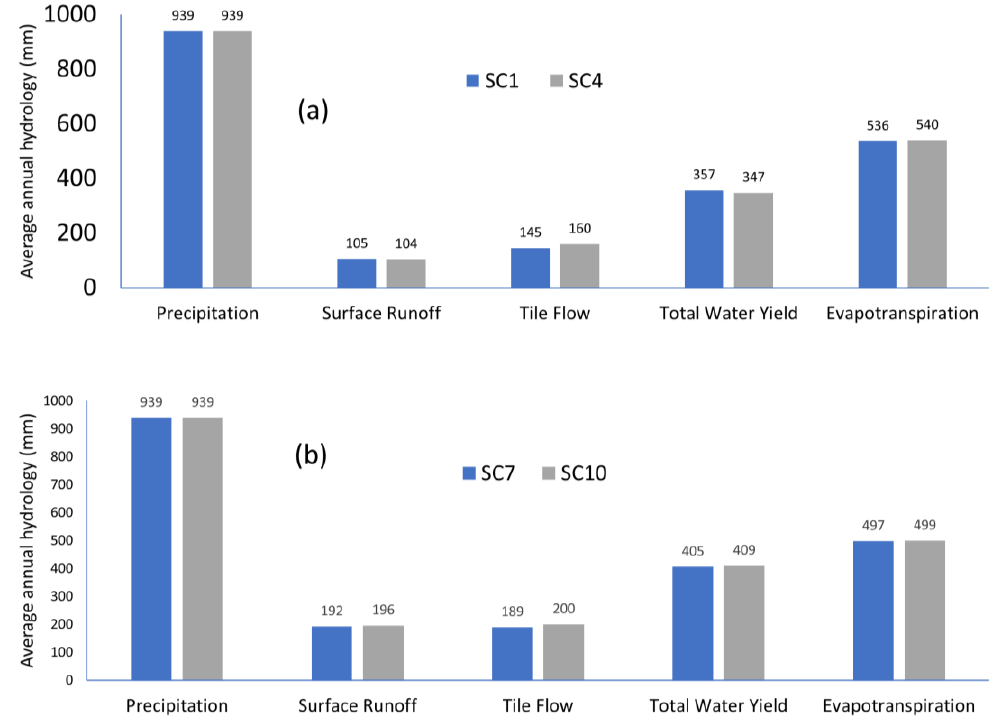
Figure 7. Water budget scenario comparison: ( a ) SC1 and SC4 land use with a combination of SLC soil and GCDC weather. ( b ) SC7 and SC10 land use with combination of FAO soil and GCDC weather.